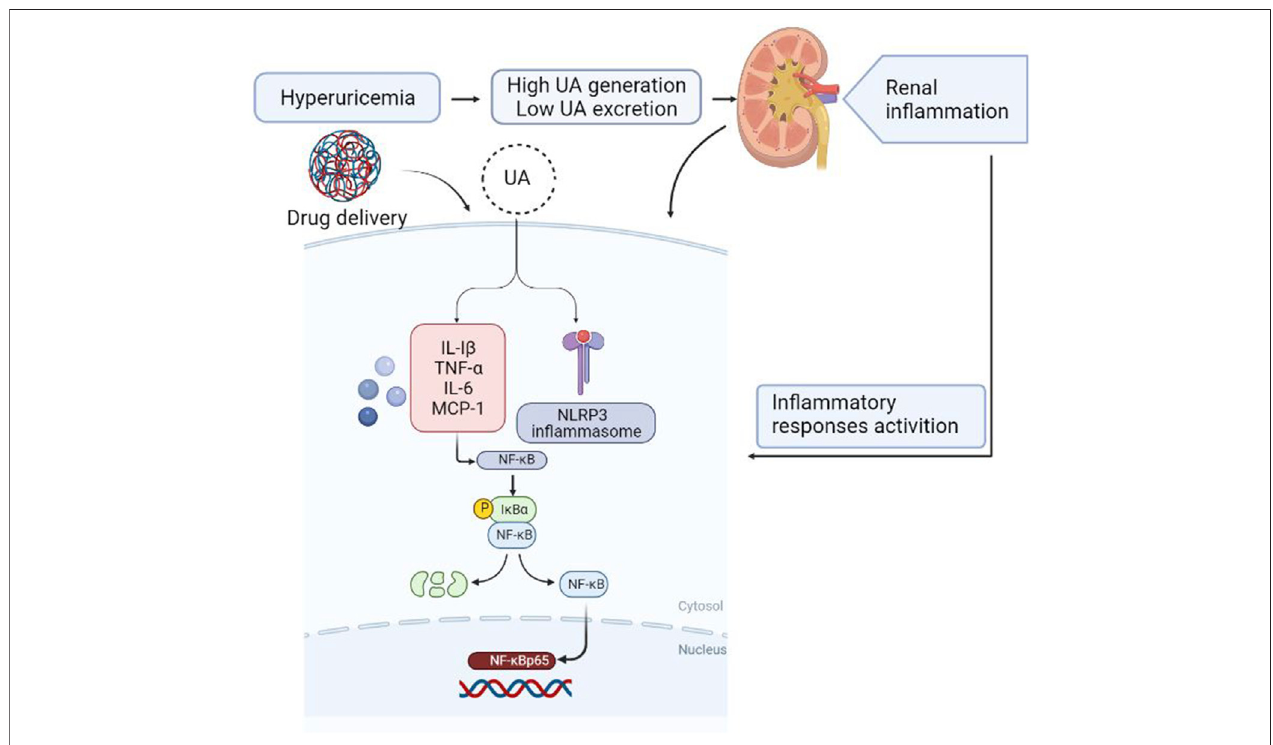
FIGURE 11 | Diagram of the speculative mechanism how the drug affects in fl ammation induced by hyperuricemia in the kidney generated using BioRender.